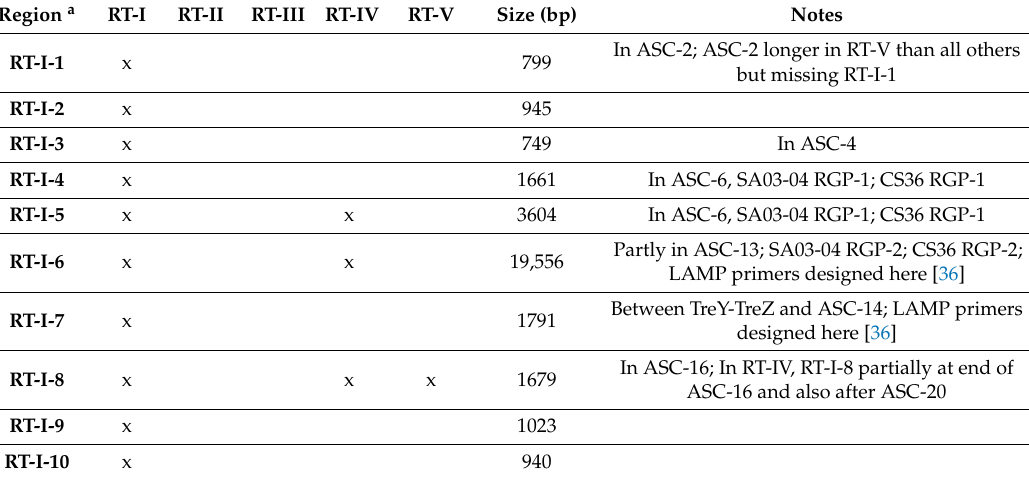
Table 3. Unique regions determined by PanSeq for each population of R. toxicus